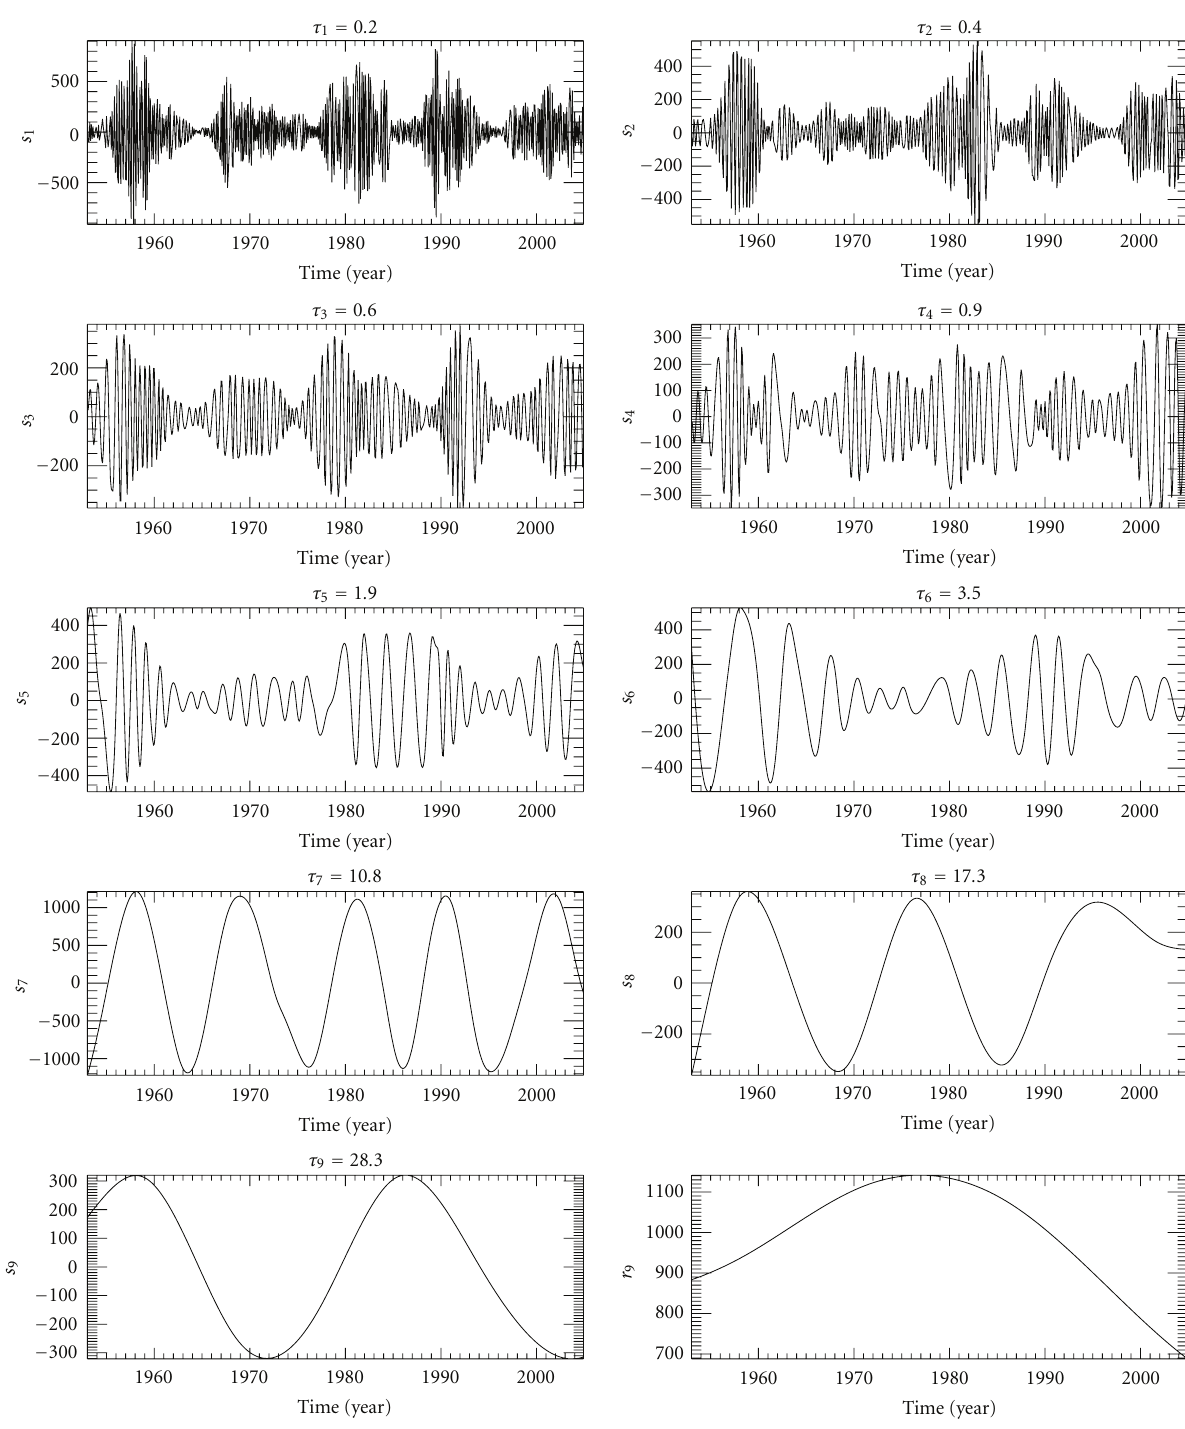
of both j = 7,9 IMFs is fundamental to take into account the full contribution of the drifts to the CR modulation.